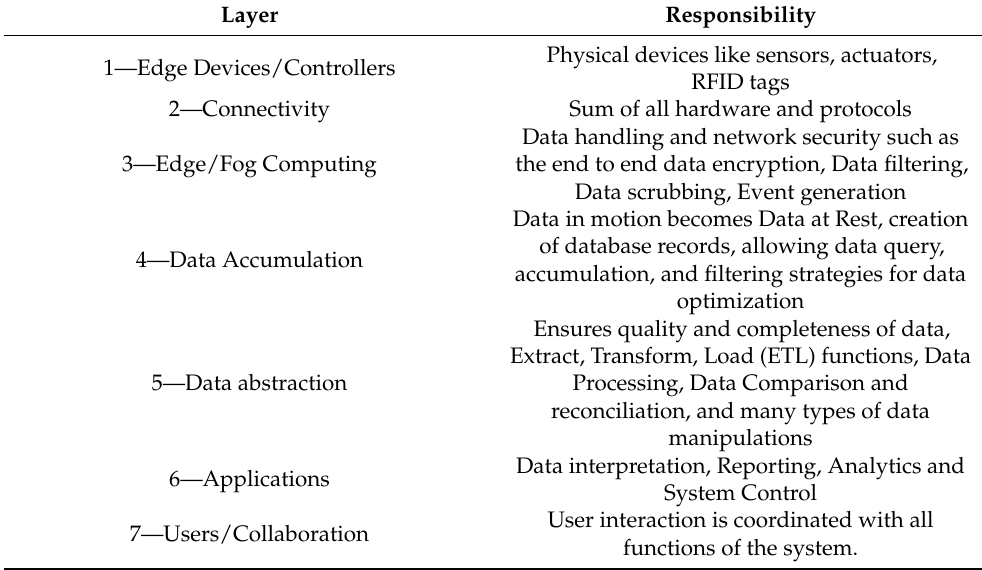
Table 2. Layers and respective responsibilities of the IWF Architecture.